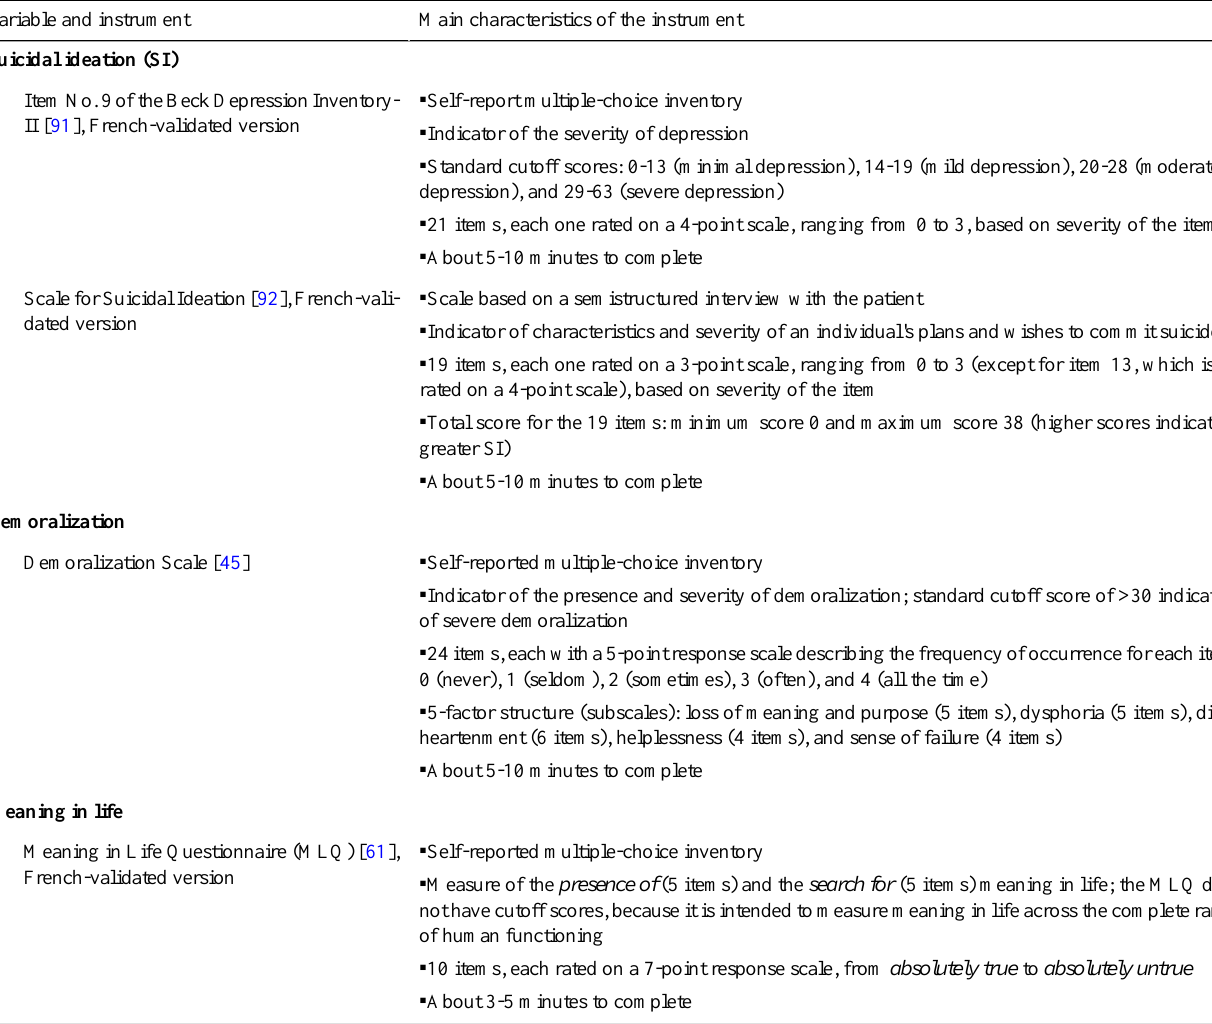
Table 1. Methodological tools to assess primary outcomes.